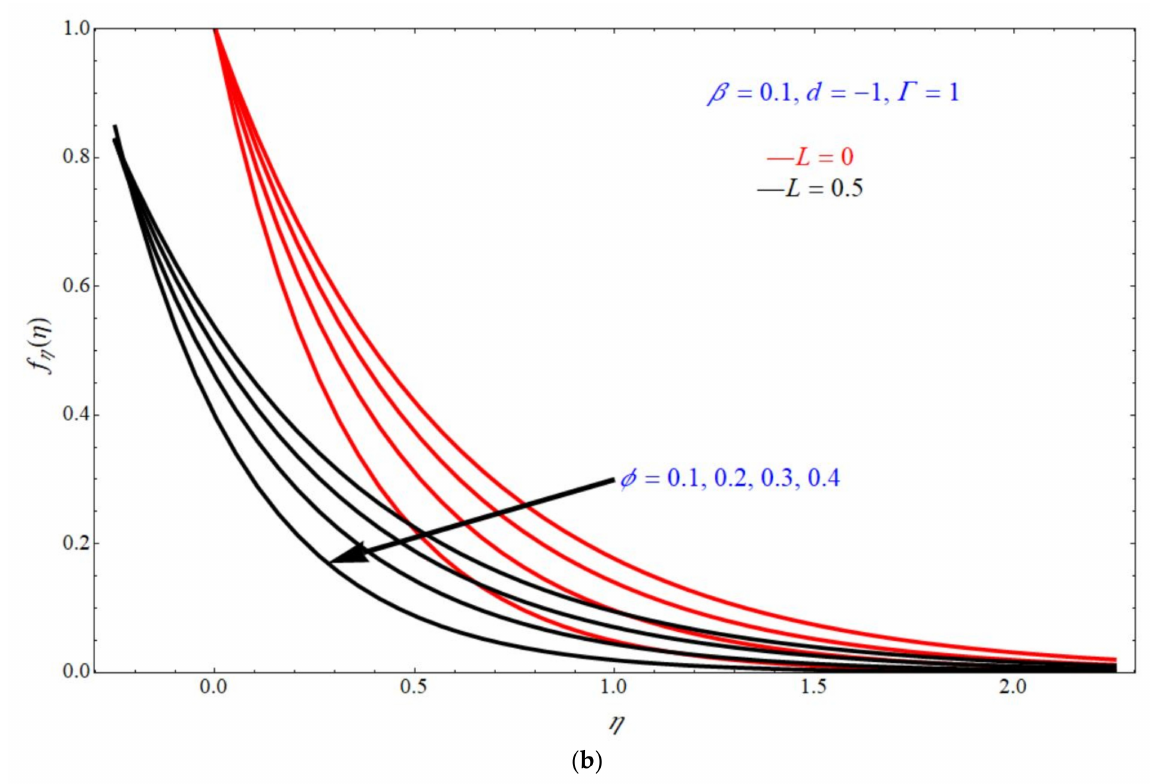
Figure 3. Impact of f η ( η ) on η for various choices of ( a ) β and ( b ) φ . Equation (25) depicts the analytical expression of the energy equation along with a Biot number; this expression can provide the analytical solution of the temperature for Γ , R , φ & β ; the thermal analysis is valid for Pr = 6.2, β < 1, φ < 1 and the slip parameter is fixed to L = 1. According to the laminar boundary layer theory, the dependence of all these numbers and parameters are discussed below. Figures 4–7 depict the impact of temperature profile θ ( η ) verses similarity variable η for different choices of different physical parameters. Figure 4a,b depict the impact of θ ( η ) verses η for various values of Γ at d = 1 and d = − 1, respectively, with the fixed parameters φ = β = 0.1, R = Bi = 1. In both the stretching and shrinking cases, the θ ( η ) increases with an increase in the values of Γ . θ ( η ) increases with increases in the values of R for both d = 1 and d = − 1 indicated, respectively, in Figure 5a,b. In this case, the other parameters are fixed to φ = Γ = β = 0.1, Bi = 1. Figure 6a,b depict the impact of θ ( η ) verses η for various choices of φ ; here, it is seen that θ ( η ) increases with increases of φ for both stretching and shrinking cases, and the other parameters are fixed to Γ = β = 0.1, R = Bi = 1. Figure 7a,b demonstrate the effect of temperature profile θ ( η ) verses η for various values of β , keeping the other parameters as φ = Γ = 0.1, R = Bi = 1. Here, it is seen that θ ( η ) increases with an increase in the values of β for both d = 1 and d = −